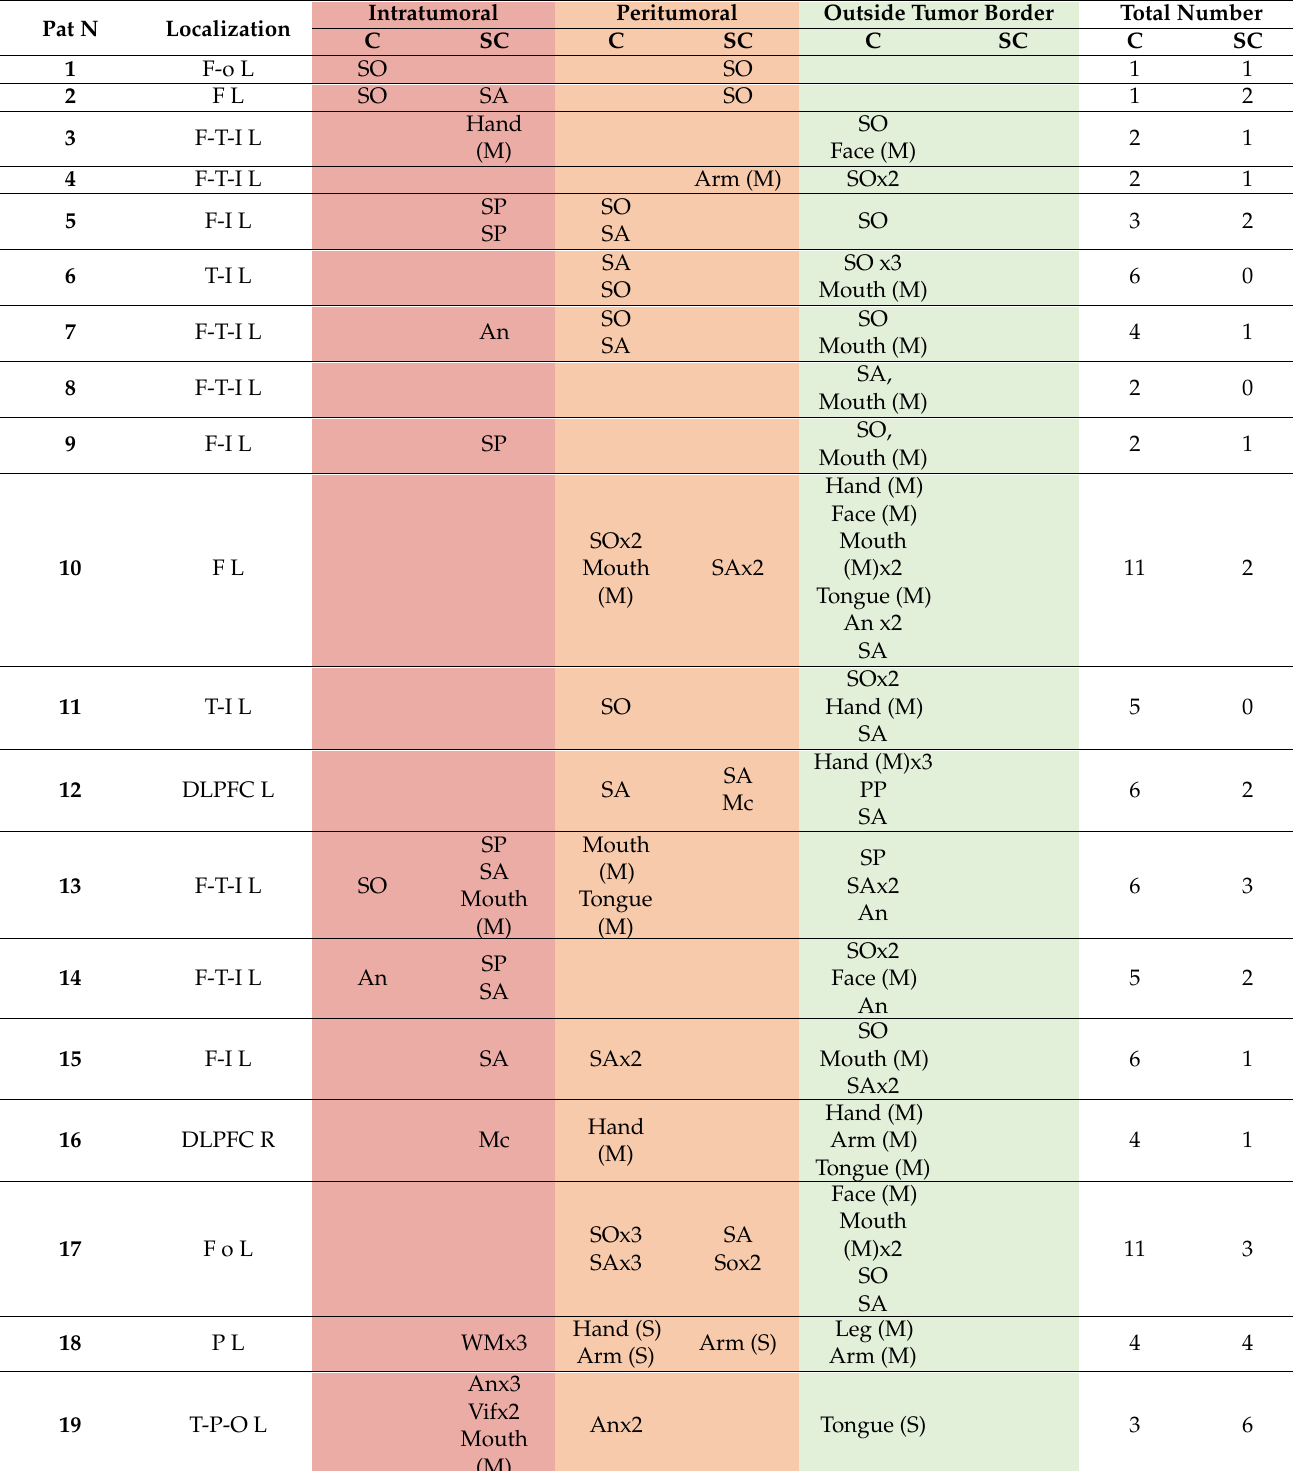
Table 2. A summary of the intraoperative eloquent spots displayed for each patient and organized according to the proximity to the FLAIR signal. Spots acquired within the FLAIR tumor signal were considered intratumoral (red color shading, cortical or subcortical). Spots acquired within 1–10 mm from the tumor border were included as peritumoral (orange color shading, cortical or subcortical). Those spots acquired with a distance superior to 10 mm were considered outside the tumor border (green color shading, cortical or